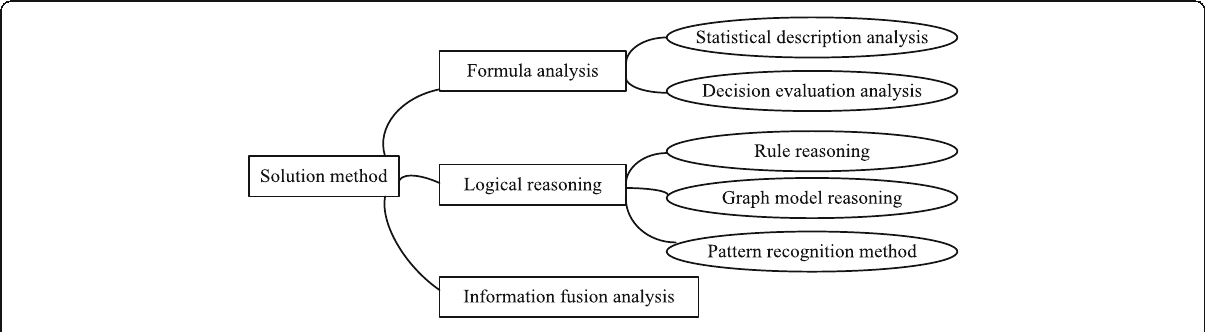
Fig. 12 Classification of network security situation aware solution analysis